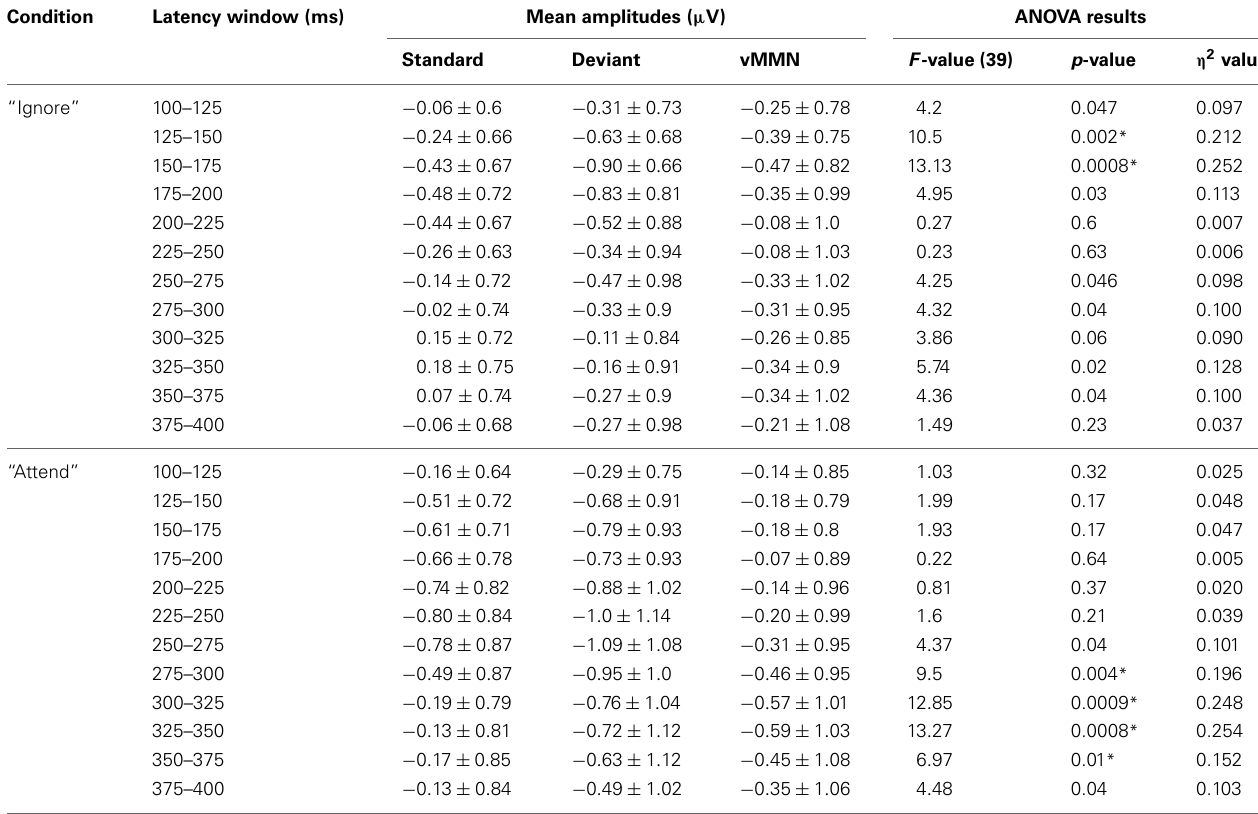
Table 2 | Mean amplitudes of standard, deviant and difference (vMMN) waveforms and repeated measures ANOVA results showing the comparison of standard and deviant mean amplitude for each latency window and condition in Parietal area for 40